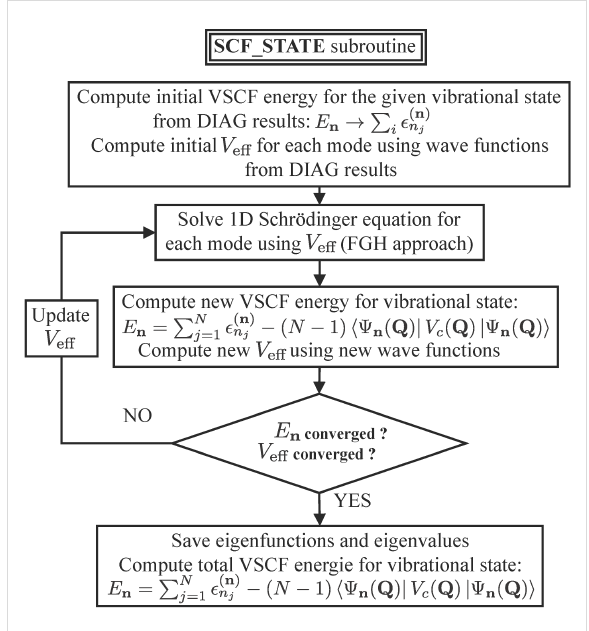
Figure 2: Flow-chart diagram of the computer code used to compute the VSCF state